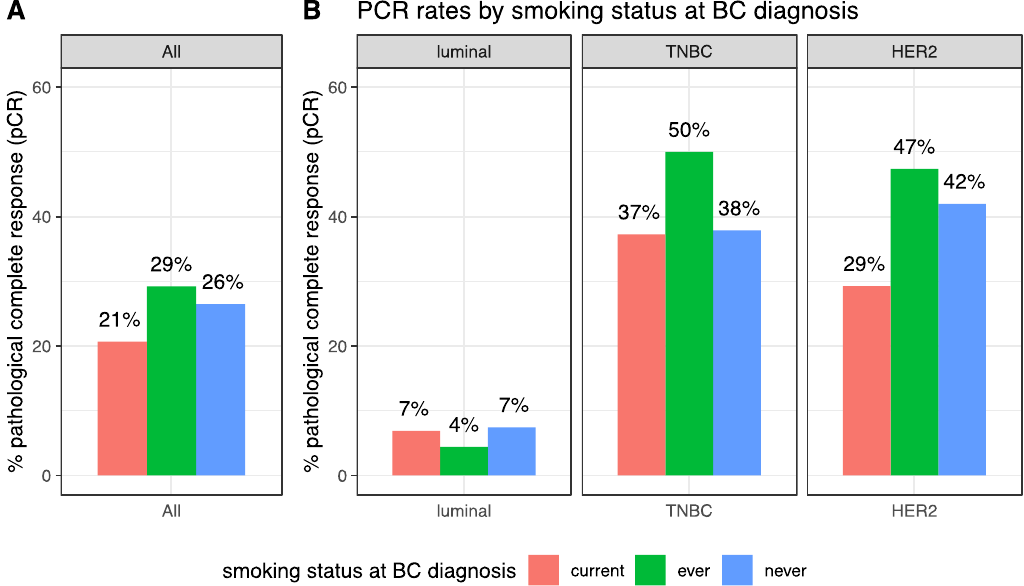
Figure 2. pCR rates according to smoking status at BC diagnosis, in the whole population ( A ) and by BC subtype ( B BC subtype ( B ).